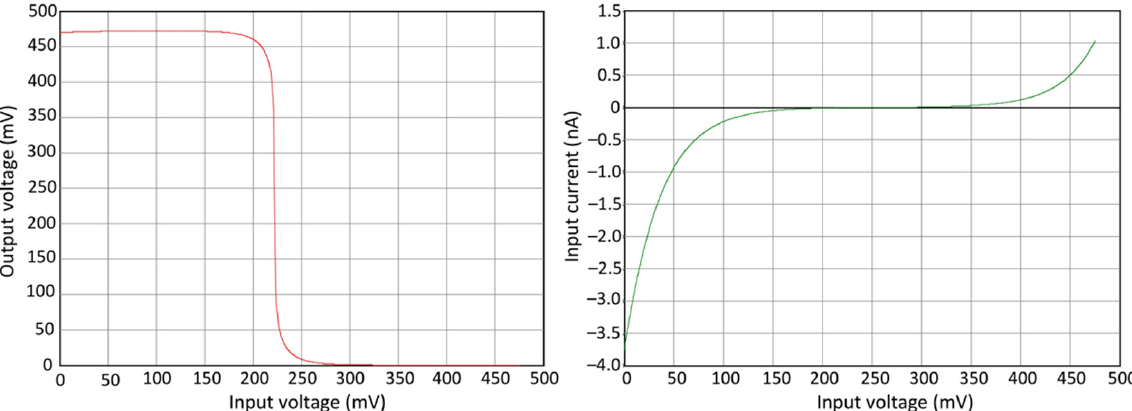
Figure 10. Transfer characteristic and input current of a thermally stabilized CBip inverter (Figures 7 and 8). V CC = 1 V, R = 10 M Ω , temperature 400 K.